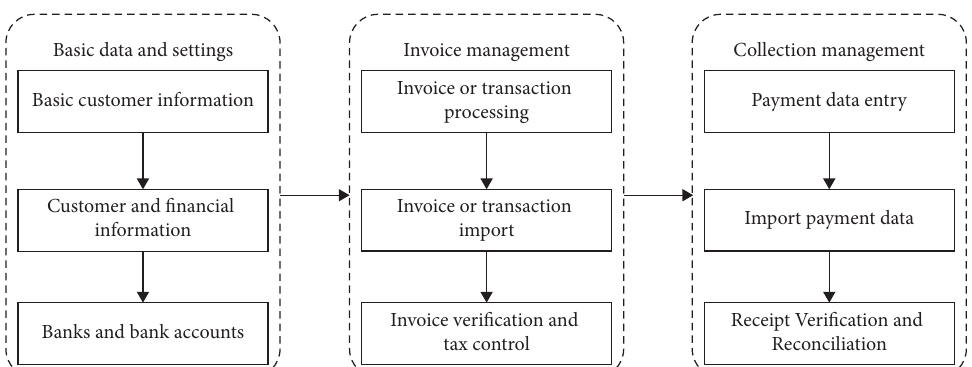
Figure 4: Core functions and business fowchart of accounts receivable segment.